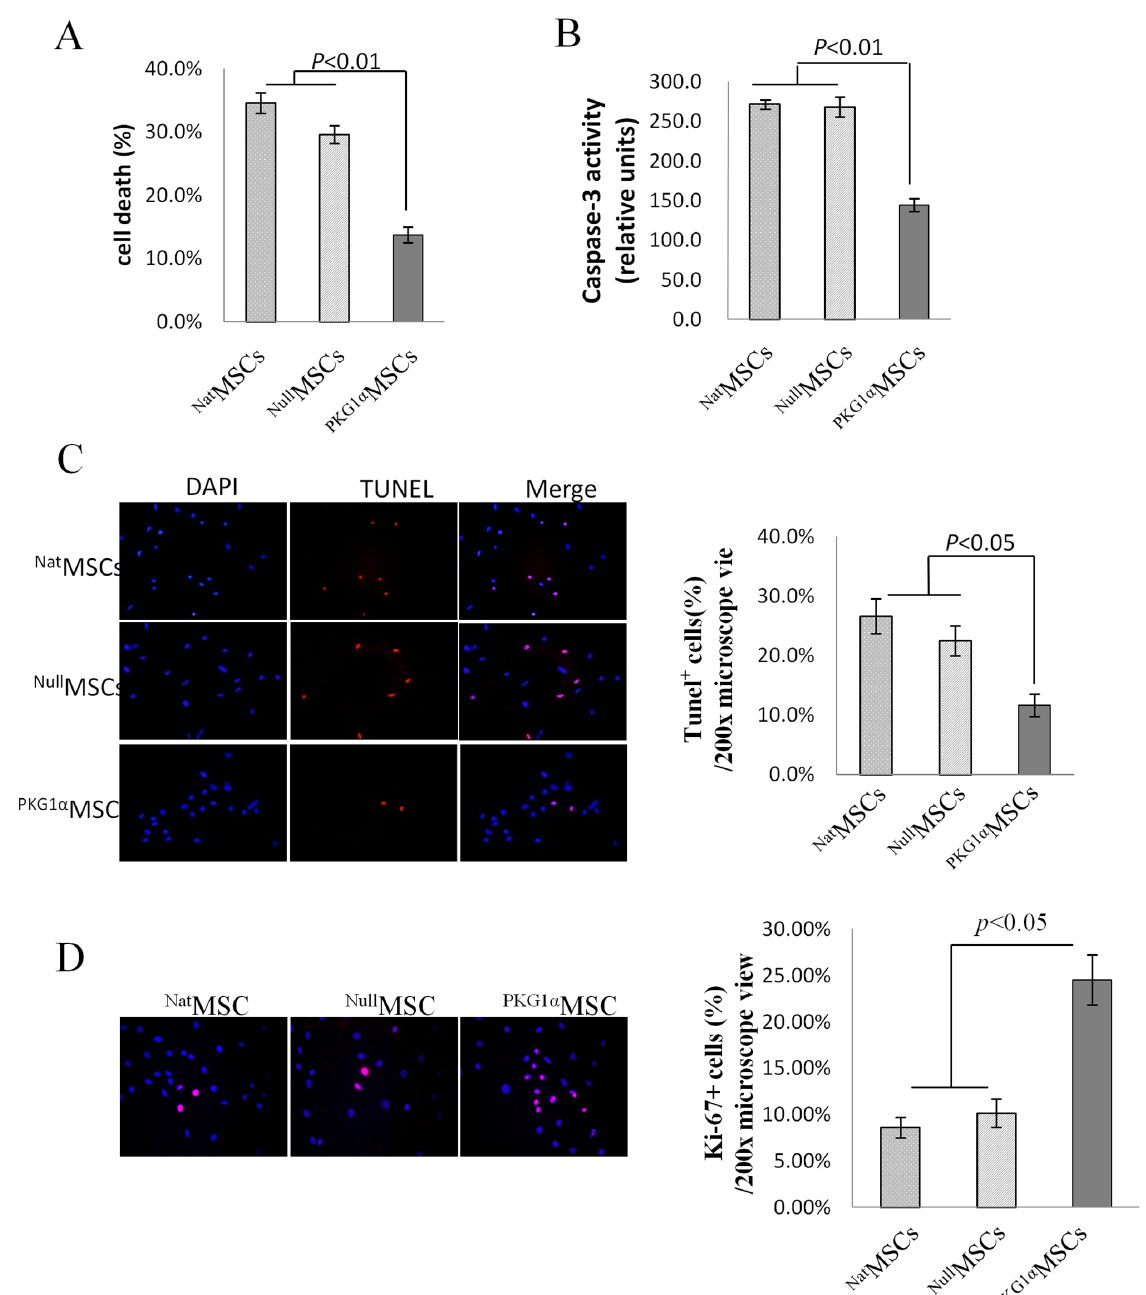
Figure 2. Effect of PKG1 a overexpression on MSCs survival. (A) LDH release assay showed less cell death on PKG1 a MSCs at 8 h after exposure to oxygen glucose deprivation (OGD); (B) Parallel experiments were performed to show that caspase-3/7 activity was significantly decreased in PKG1 a MSCs with concomitant increase in cell survival as determined by LDH release assay; (C–D) TUNEL and Ki67 staining on MSCs showed decreased number of TUNEL( + ) cells and increased Ki67( + ) cells in PKG1 a MSCs compare with Nat MSCs and Null MSCs after 8 h OGD. The nuclei were visualized by staining with DAPI (blue). Magnification 6 400. doi:10.1371/journal.pone.0060087.g002 activity were also significantly increased in PKG1 a MSCs group there were no animal deaths related to PKG1 a transgene overexpression in the infarcted heart. Analysis of the LV tissue (Fig. 4C). samples by RT-PCR showed that the transplanted cells continued PKG1 a improved survival of transplanted MSCs and cardiomyocytes in rats with acute myocardial to overexpress PKG1 a at the site of the cell graft in rat hearts. The infarction. DMEM group did not show any amplification of level of PKG1 a transgene expression on day 3 was elevated in PKG1 a MSCs group compared to DMEM and Null MSCs group sry-gene as there were no transplanted male MSCs. Compared to Null MSCs group, PKG1 a MSCs group had a significantly higher (Fig. 4A). PKG1 a protein expression (Fig. 4B, p , 0.01) and PKG